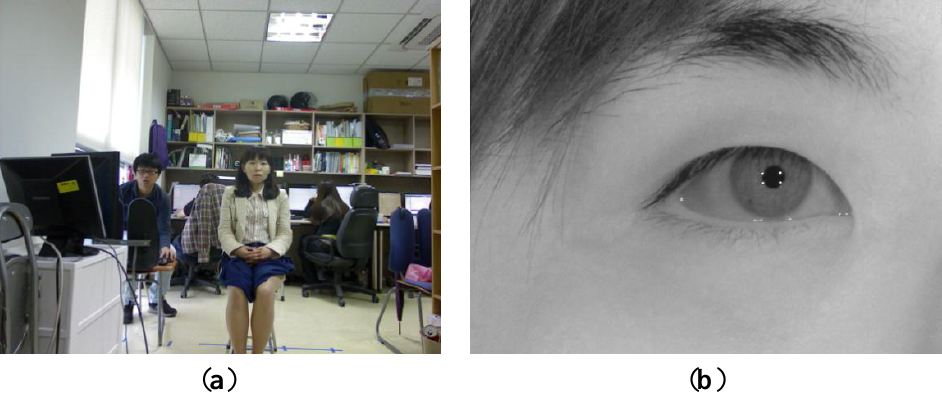
Figure 4. Captured images by the proposed device. ( a ) Captured image by the WVC. ( b ) Captured image by the